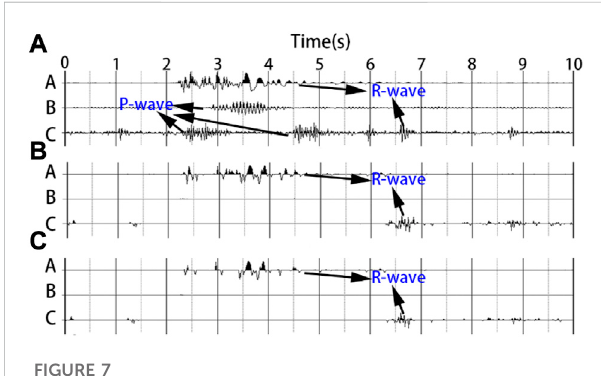
FIGURE 7 Seismic records, A, B and C are vertical component seismic records including Rayleigh surface wave, body wave and Rayleigh surface wave respectively. (A) Is the original record; (B, C) are the results of (A) polarization fi ltering and phase difference fi ltering,